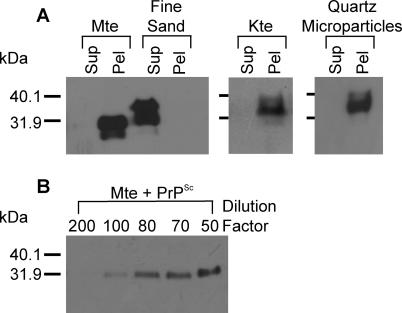
PrPSc Adsorption to Clay Minerals and Quartz Microparticles Substantially Exceeded That to Fine Quartz Sand(A) Detectable amounts of PrPSc adsorbed to Mte and Kte but not to fine quartz sand (d
h = 125–250 μm). PrPSc desorbed from Mte was of lower molecular mass than the starting material. Adsorption to quartz was observed when quartz microparticles (d
h = 1–5 μm) were employed and surface area was matched to Mte.(B) Immunoblotting sensitivity was determined by dilution of Mte-adsorbed PrPSc to the limit of detection. Protein was desorbed from Mte in 50 μl of SDS-PAGE sample buffer at 100 °C and serially diluted. Immunoblots used monoclonal antibody (mAb) 3F4. Pel, PrPSc associated with pelleted mineral particles; Sup, unbound PrPSc in supernatant.